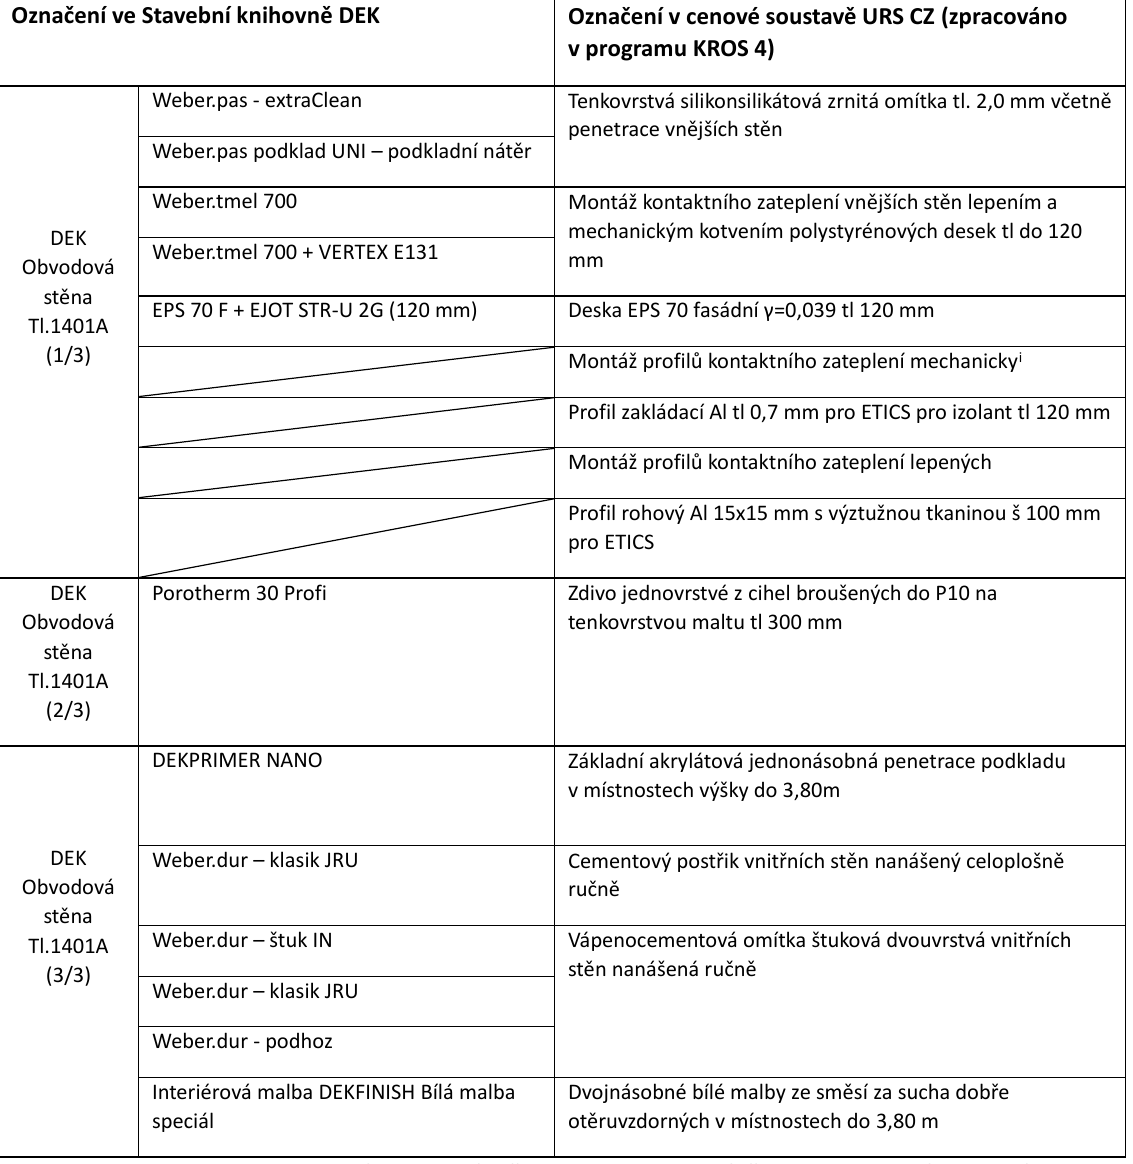
Tabulka 3: Skladba elementu nosné obvodové stěny BIM modelu vyjádřena terminologií Stavební knihovny DEK a cenové soustavy URS CZ-program KROS 4 (zdroj: ČERNOVICKÝ, Vojtěch. Bakalářská práce. V Praze: